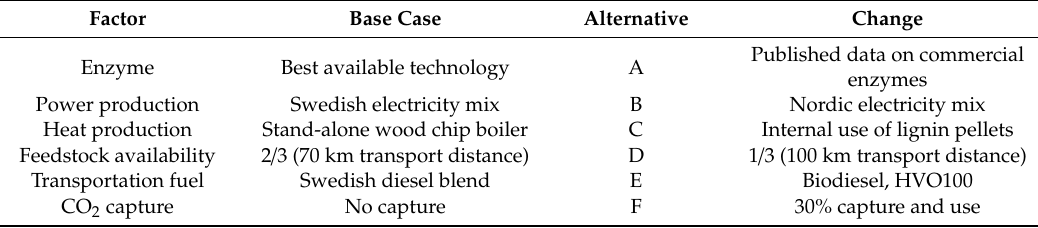
Table 1. Overview of the alternative cases